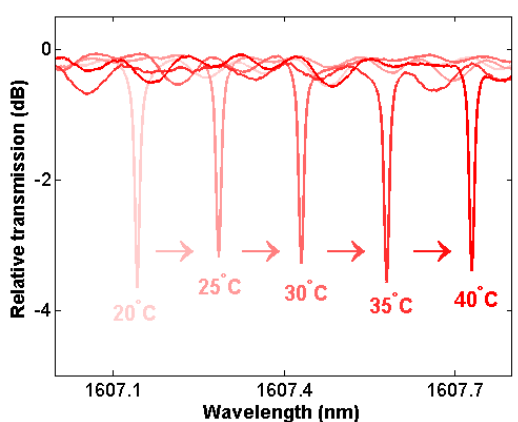
Figure 3. Resonance spectra measured at temperatures ranging from 20 to 40 °C for the microcavity with a 1100-nm-thick TeO 2 film, showing shifting of the resonance wavelength.